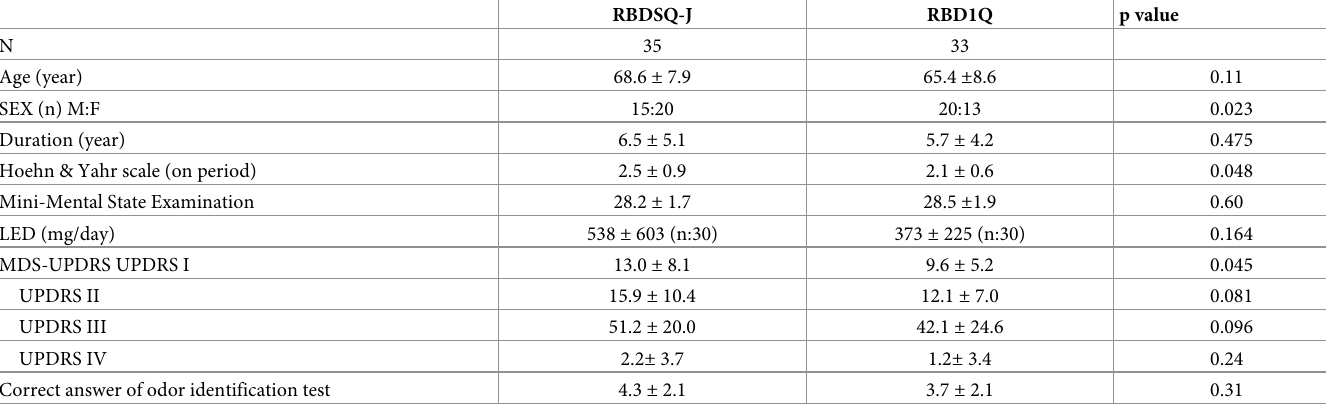
Table 2. Comparison of characteristics between patients with PD and pRBD only by the RBDSQ-J and